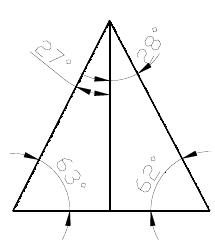
Figure 5. Fitted triangle angles of incisor lobe.